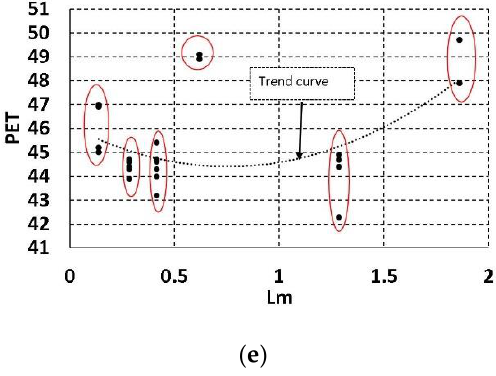
Figure 12. PET versus input model variables.